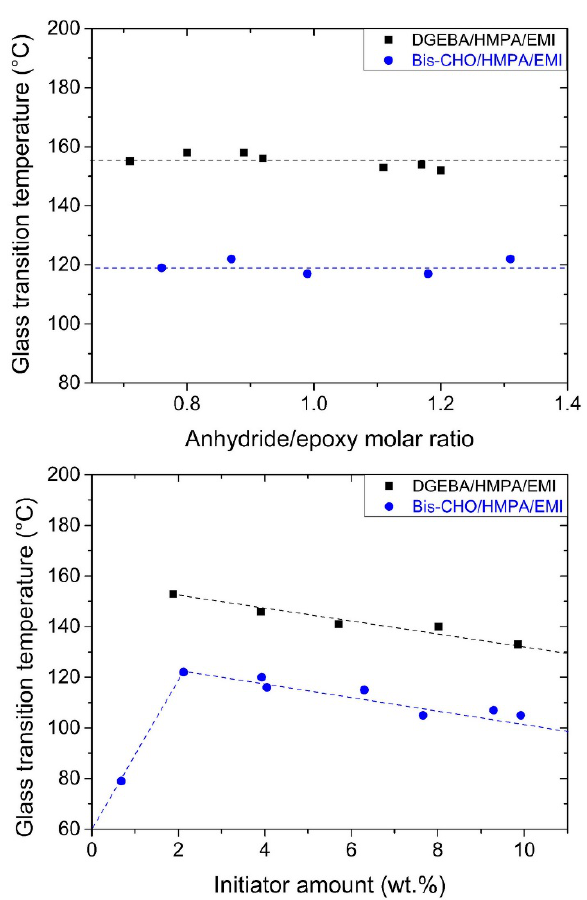
Figure 6. Influence of ( top ) thermoset stoichiometry and ( bottom ) initiator amount on glass transition temperature, for Bis-CHO/HMPA/EMI and DGEBA/HMPA/EMI thermosets.